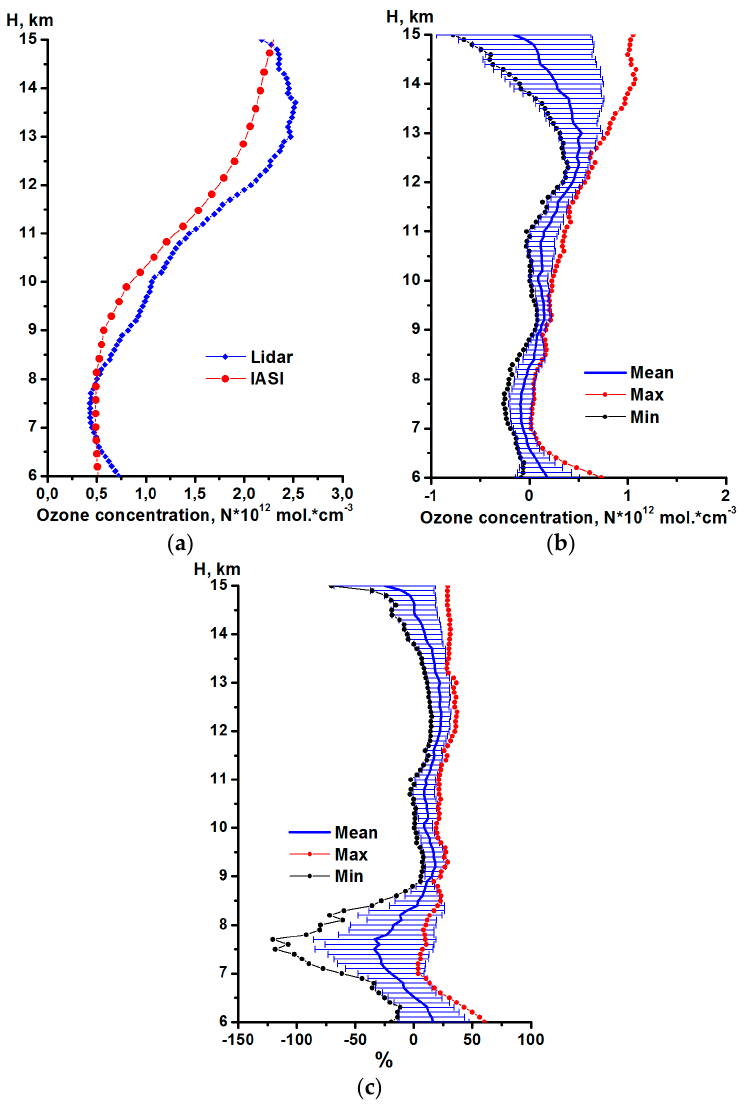
Figure 7. Mean vertical profiles of ozone ( a ), their difference (Lidar–IASI) in abs. units ( b ), and the relative difference (Lidar–IASI)/lidar ( c ).